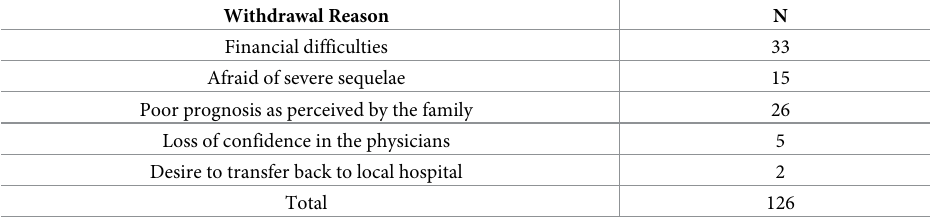
Table 3. Reasons to withdraw care in the withdrawal group. More than one reasons could be found in patients’